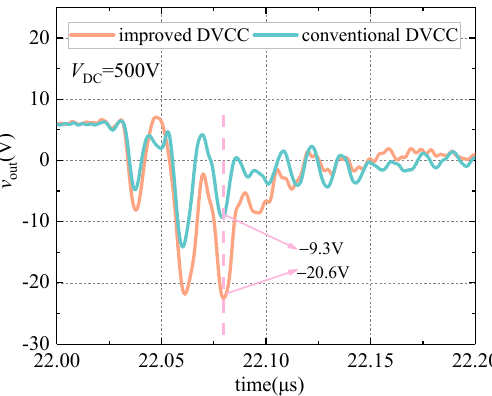
Figure 8. v out waveform comparison during the on - oscillation state.